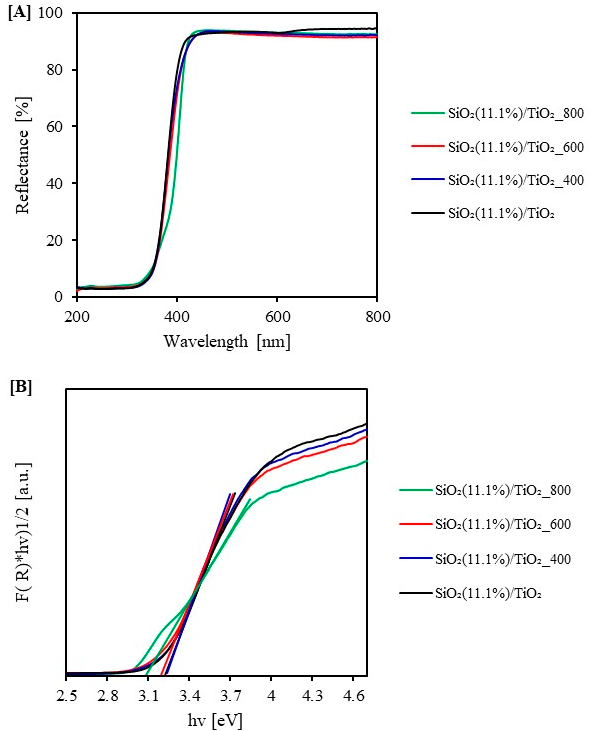
Figure 5. UV-Vis/DR spectra ( A ) and Tauc plot ( B ) for fumed silica-modified TiO 2 before and after heat treatment. Table 3. The zeta potential values of starting TiO 2 , reference samples and fumed silica-modified photocatalysts prior to and after heat